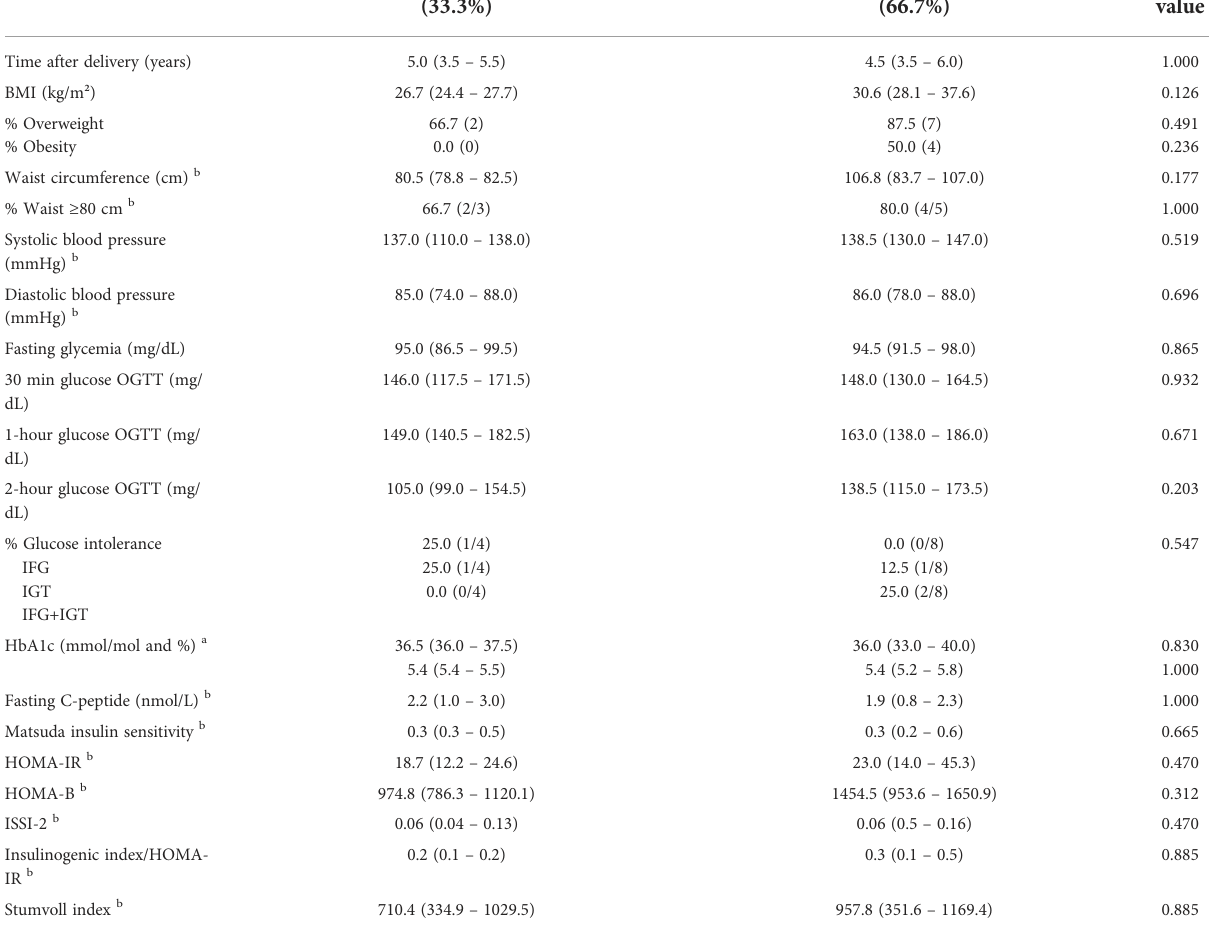
TABLE 4 Comparison of long-term follow-up data among women with a history of GDM and T1D-related autoantibodies in pregnancy